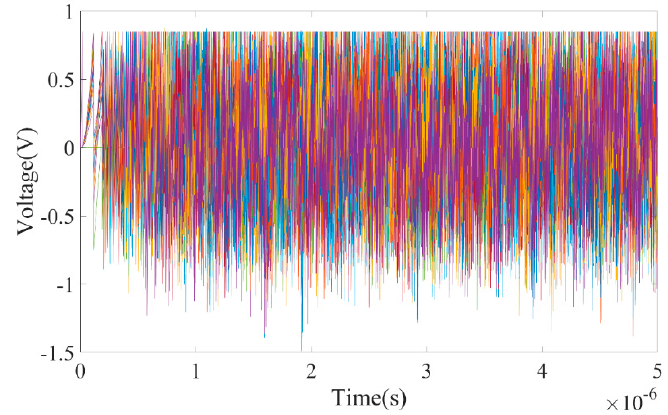
Figure 11. Terminal voltage response of each memristor.